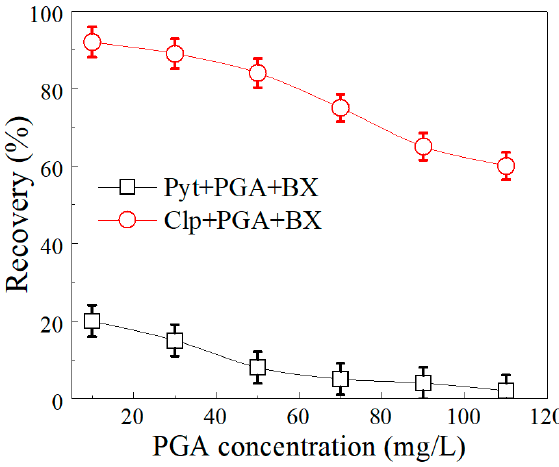
Figure 5. Flotation results of pyrrhotite (Pyt) and chalcopyrite (Clp) at different PGA concentrations, 20 mg/L SBX, and pH 8.